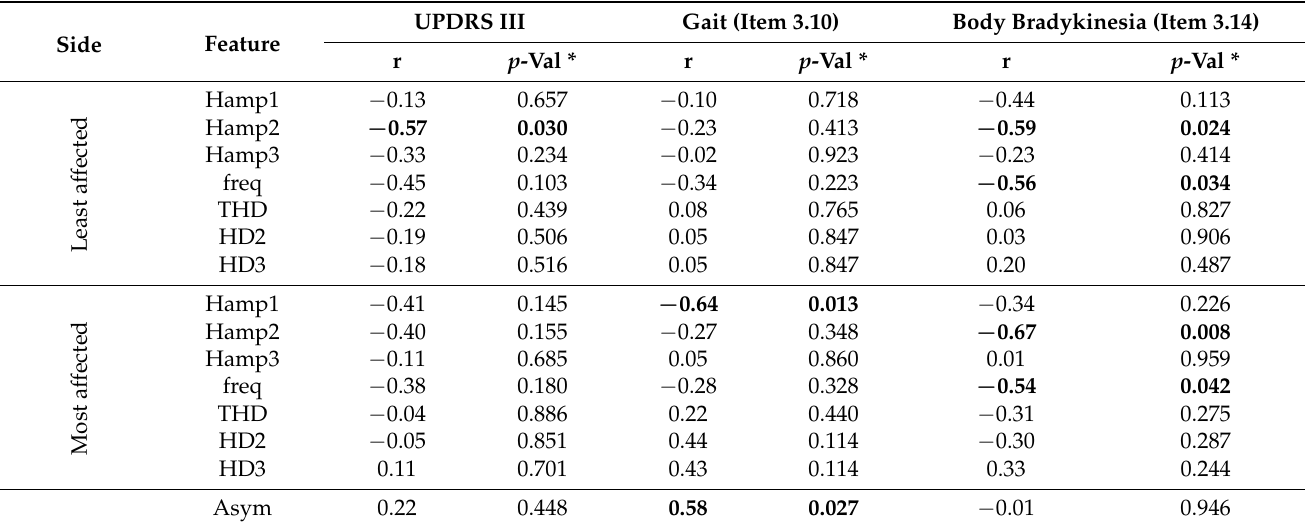
Table 6. Spearman’s rank correlation coefficients for the “most affected” and “least affected” sides in patients with Parkinson’s disease when in off state of therapy.